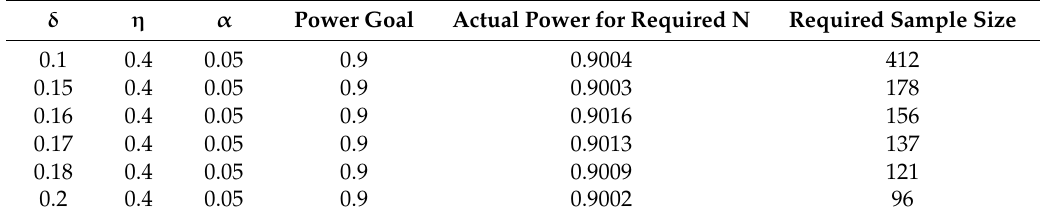
Table 3. POWER Analysis.